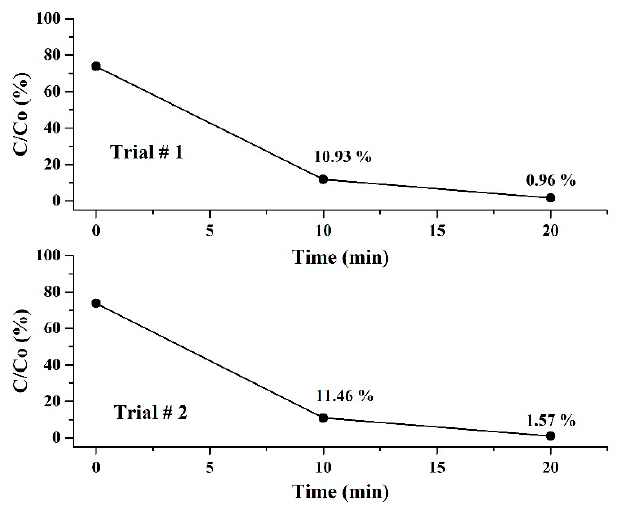
Figure 5. Reusability of ZnO-Ag photocatalysts (second and third run).